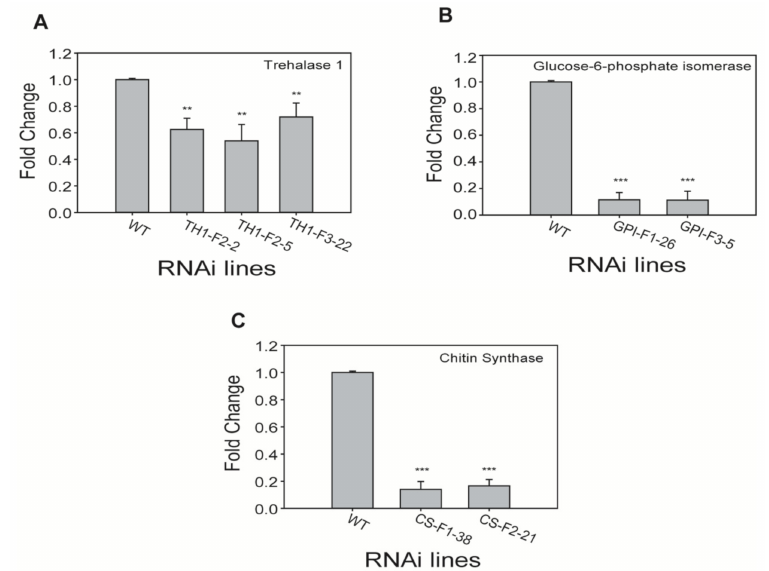
Figure 5. Transcript levels of ( A ) Trehalase 1 (TH1), ( B ) Glucose-6-phosphate isomerase (GPI), and ( C ) Chitin synthase (CS) in root galls of di ff erent RNAi transgenic lines infected with M. incognita . The di ff erence in gene expression was presented as a fold change relative to the expression of the housekeeping gene ( β -actin). Results are presented as mean ± standard deviation (SD) of three independent experiments with three technical replicates. Statistical analyses ( t -test) were conducted using SigmaPlot 12.5. For t -test analysis, the WT plants’ value was used to compare with each RNAi line. Asterisk indicates significant di ff erences compared with wild-type (WT) (** p < 0.001, *** p < 0.001). 2.7. E ff ect of RNAi-Mediated Gene Silencing on Egg Number and Female Morphology in Transgenic